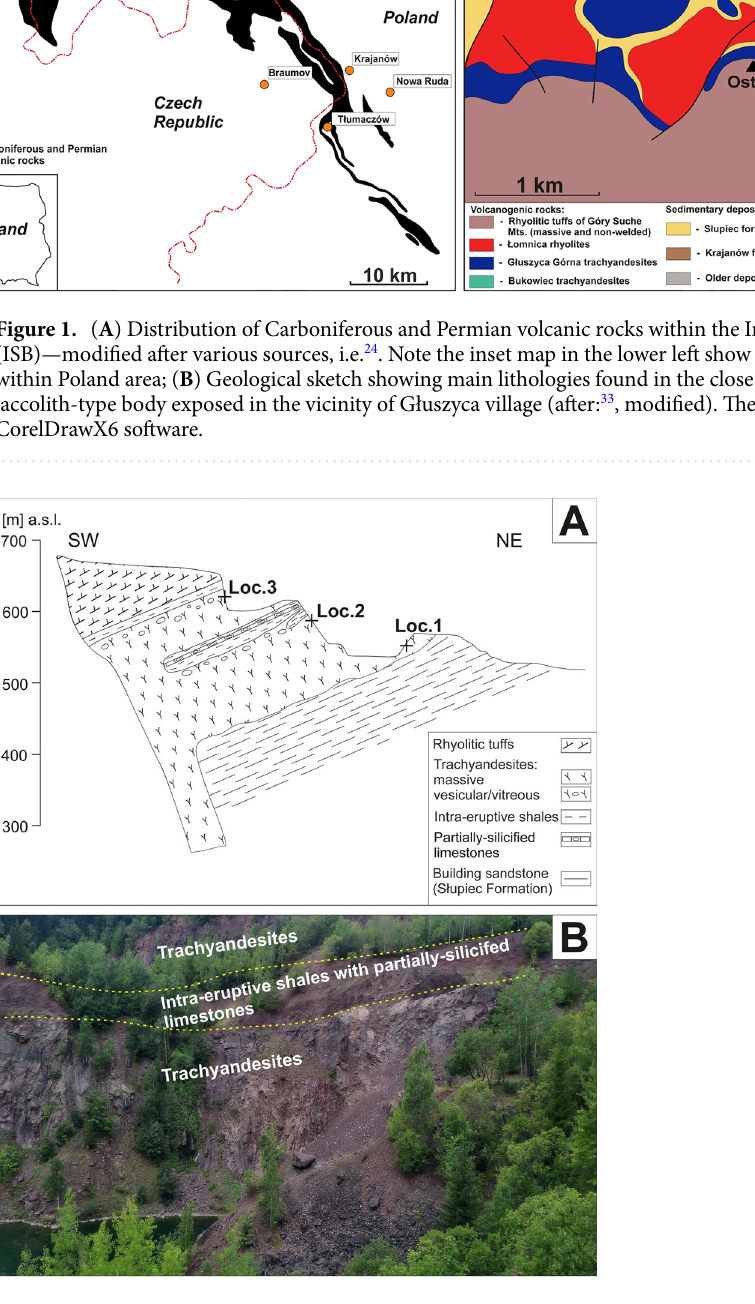
Figure 2. ( A ) Geological cross-section along A–B line (see Fig. 1B) of the subvolcanic laccolith-type magmatic body exposed abandoned Głuszyca quarry (after 31 ; modified via own field observations); Note the overall 3 sampling areas: Loc. 1 (lower parts of the laccolith), Loc. 2 (middle parts at the contact zone with adjacent intra- eruptive sediments), and Loc. 3 (top portions of the laccolith). ( B ) Field photo showing the contact between trachyandesites and intra-eruptive deposits (shales with partially-silicified limestones). The cross-section was generated using CorelDrawX6